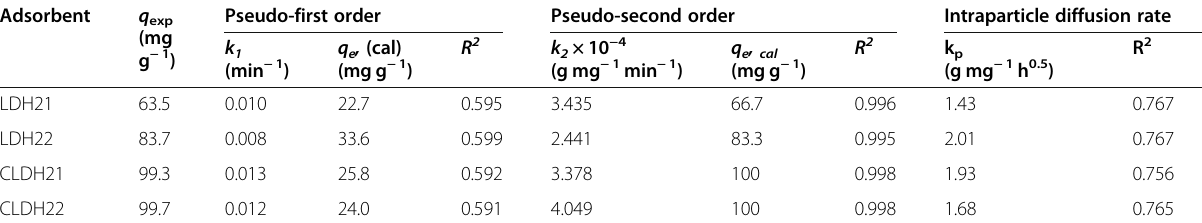
Table 3 Kinetic model constants and correlation coefficients for adsorption of IDB onto LDHs and CLDHs adsorbent, C i = 100 mg L − 1 Adsorbent q exp (mg g − 1 )